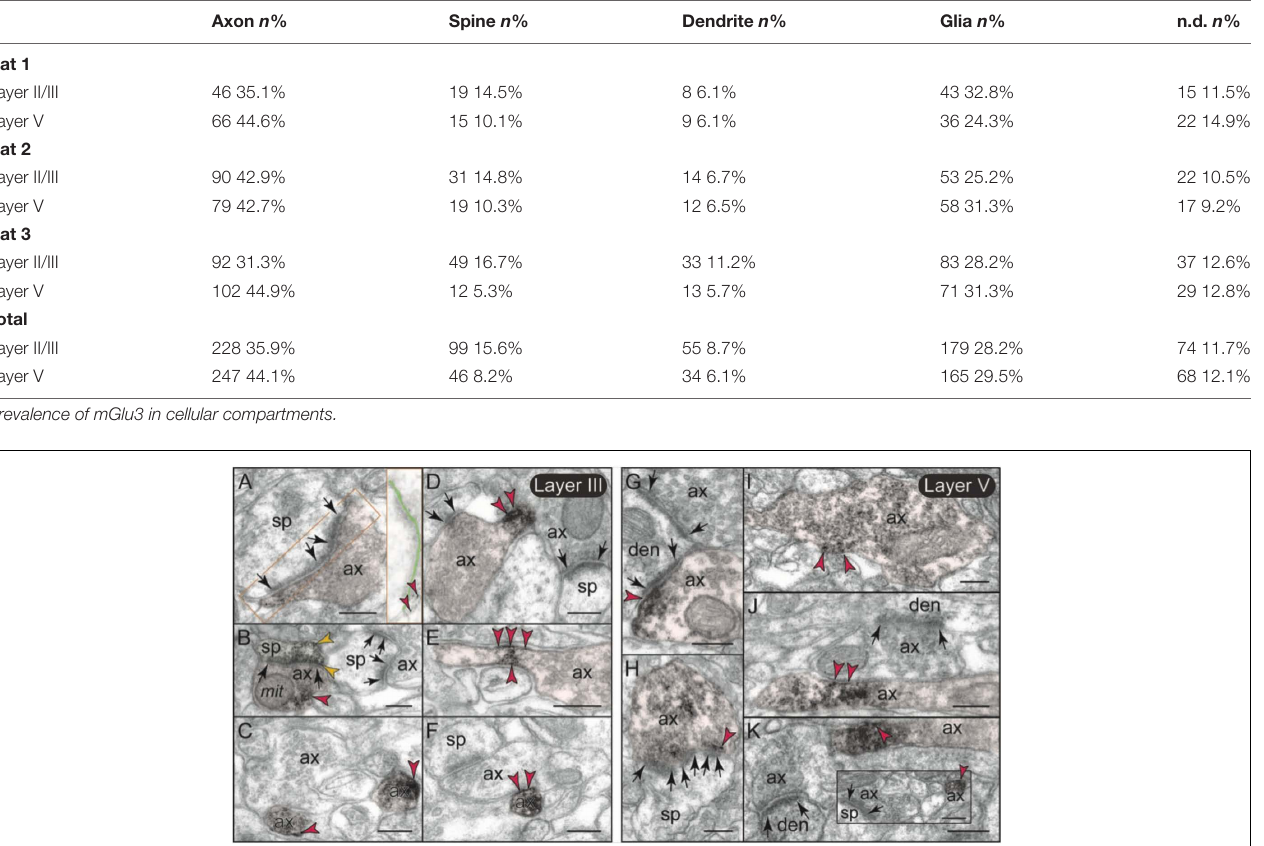
TABLE 1 | Quantitative assessment of mGlu3 immunoreactivity in rat mPFC PL layer II/III and layer V neuropil.